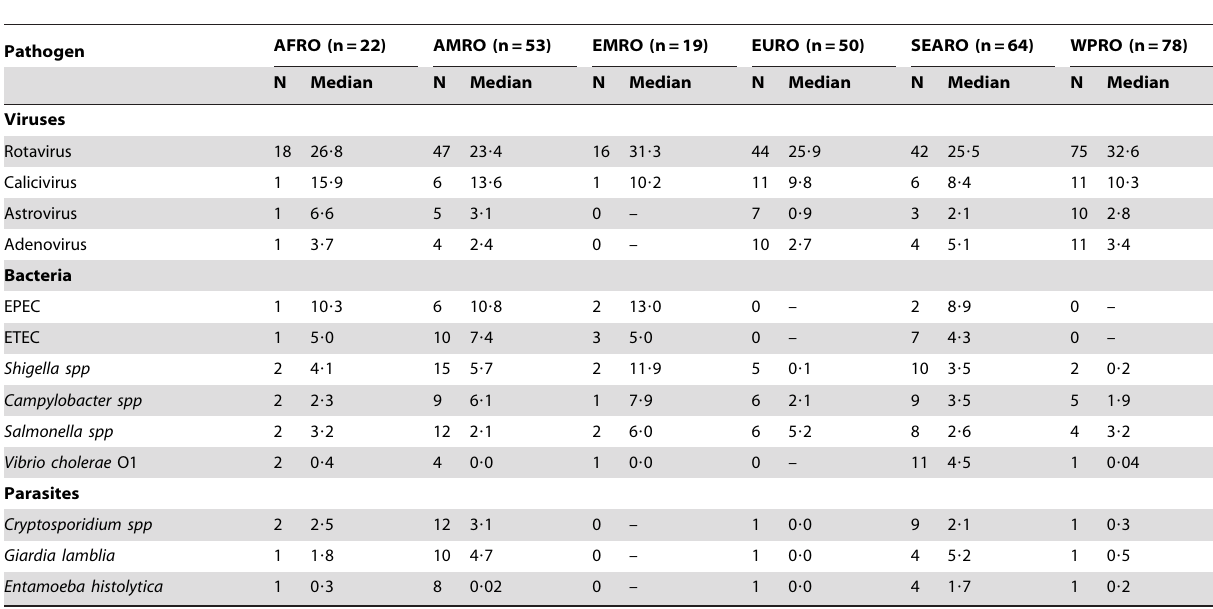
Table 5. Median age-adjusted proportions of causes of diarrhea, constrained to fit 100%, in 286 inpatients studies of children , 5 years of age published between 1990–2011, by WHO region.